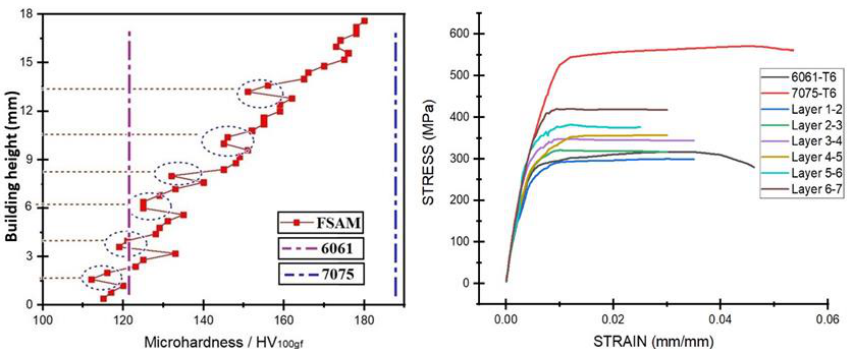
Figure 18. Microhardness and strength illustration of an alternative gradient structure obtained using the FSAM technique (reprinted from [93] permission not required).